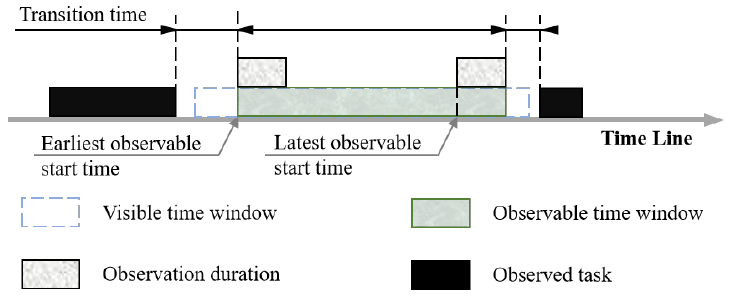
Figure 6. Task observation arrangement process.